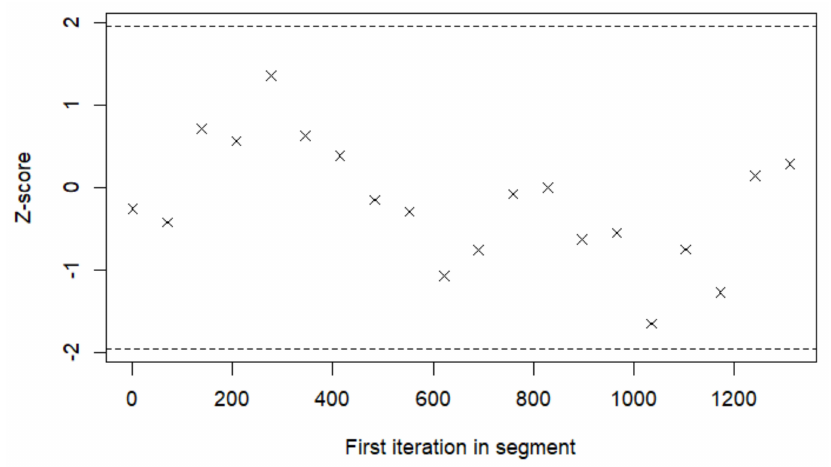
Figure A2. Development of Geweke’s Z-score when successively larger numbers of iterations are discarded from the beginning of the MCMC chain. Dashed lines corresponds to quantiles of 0.025 and 0.095 for the Z-score. No local trends are detected, i.e., a stationary sampling distribution is